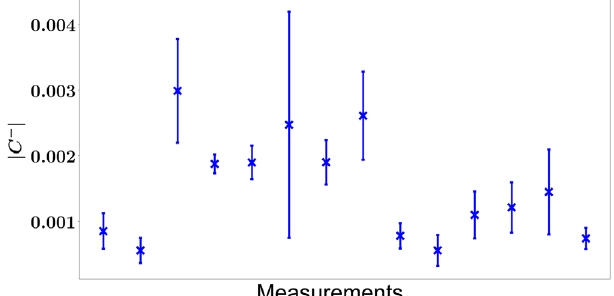
FIG. 15. Coupling in HER during the K modulation measure- ments, estimated from the spectrum of turn by turn data from all BPMs [24]. When modulating the QC1LE magnet by Δ KL=KL ¼ − 0 . 05% the estimated coupling was a lot larger j C − j ¼ 0 . 07 , this measurement also shows the largest change in the orbit, see Fig. 16.